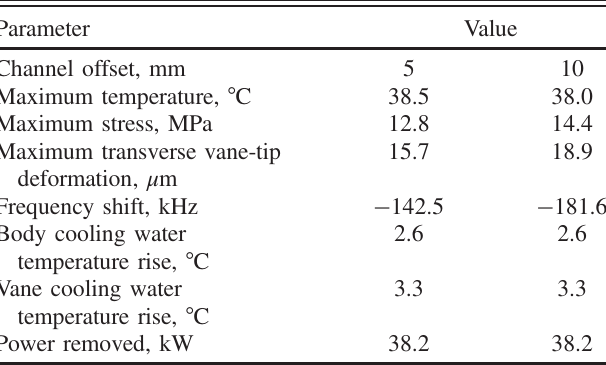
TABLE VI. Effect of channel to inner RFQ surface distance.